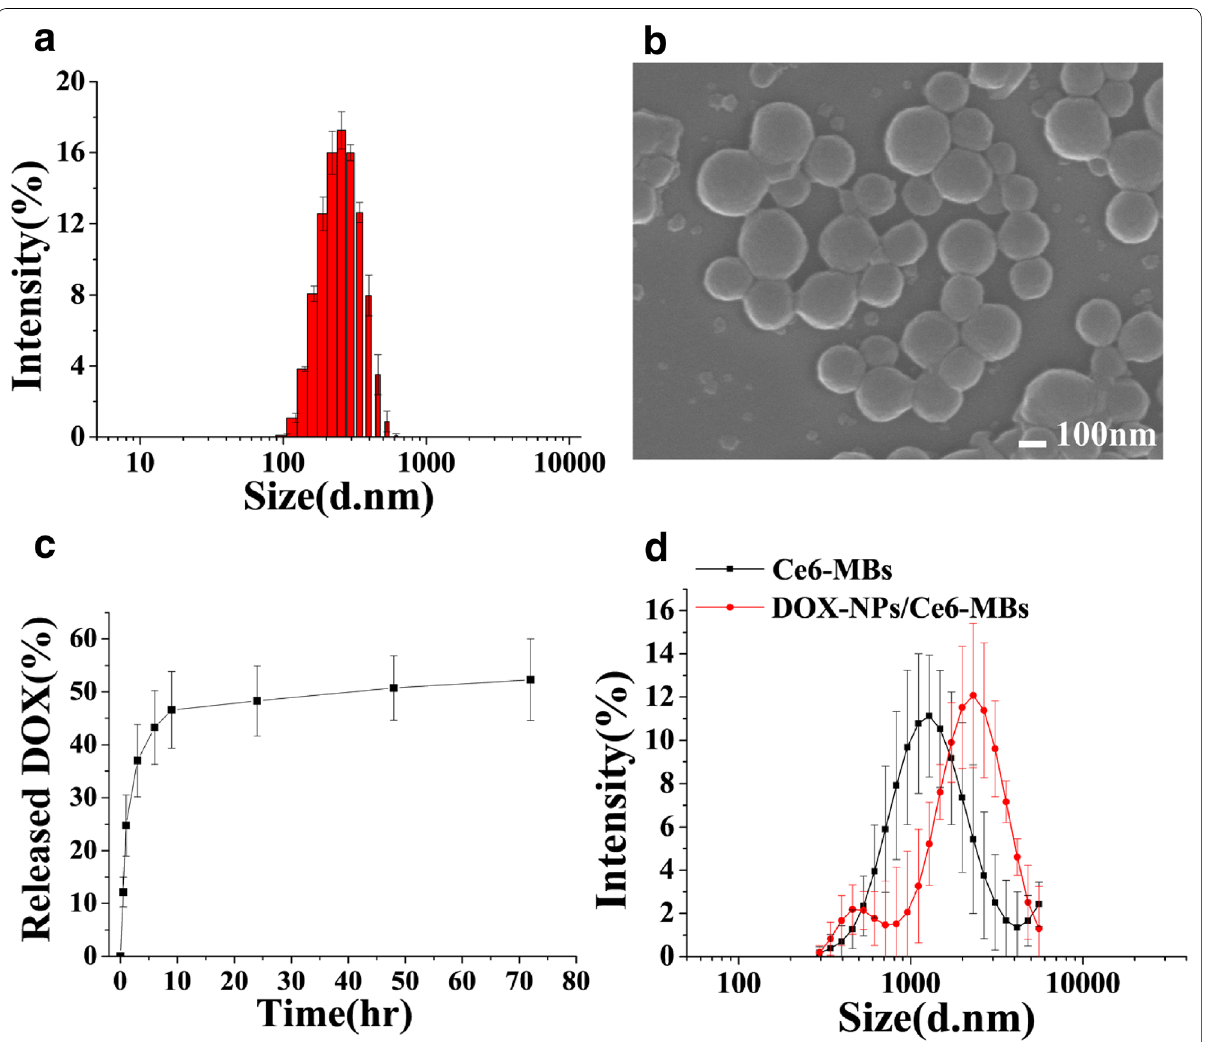
Fig. 1 Characteristics of the DOX-NPs/Ce6-MBs complex. a Size distribution of the DOX-NPs. b Scanning electron microscopy (SEM) image of DOX-NPs. Scale bar represents 100 nm. c In vitro release profile of DOX from DOX-NPs. d Size distribution of the Ce6-MBs and